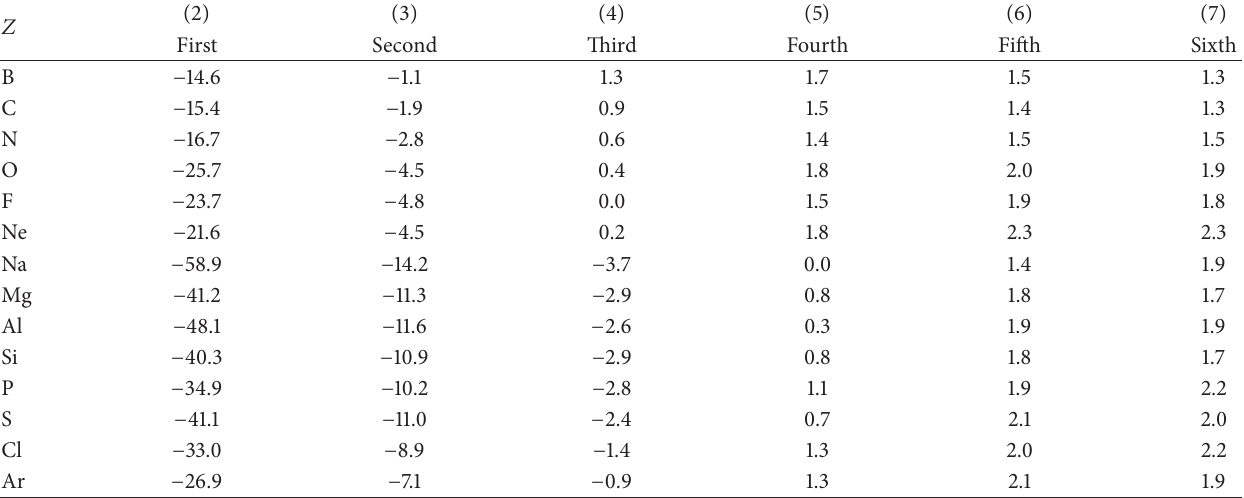
Table 11: Percentage differences between results shown in Table 10 and values from the CRC Handbook